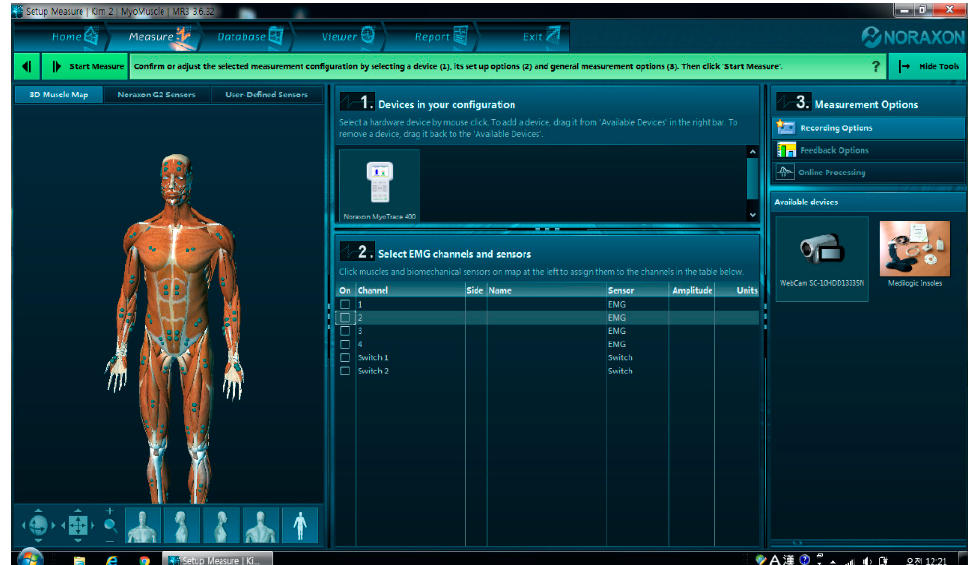
Figure 4. The initial screen.